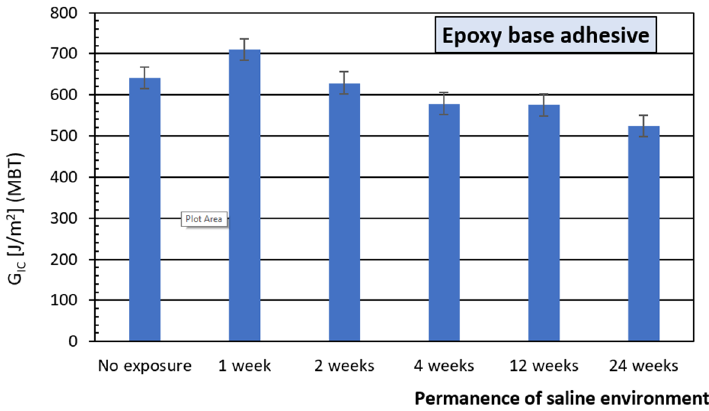
Figure 7. Energy release rate evolution under mode I of epoxy adhesive saline stress.